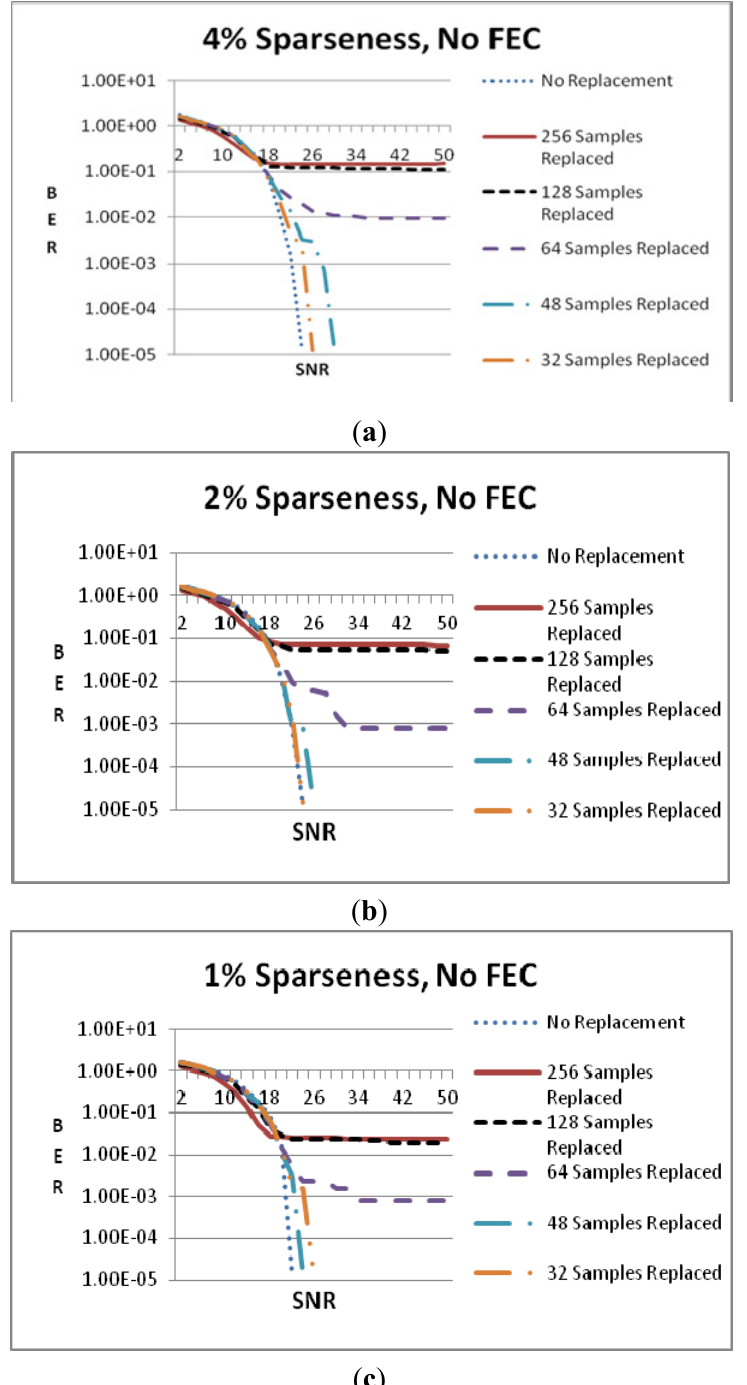
Figure 8. BER vs. SNR when no FEC is employed and the data sparseness is ( a ) 4%, ( b ) 2%, ( c )